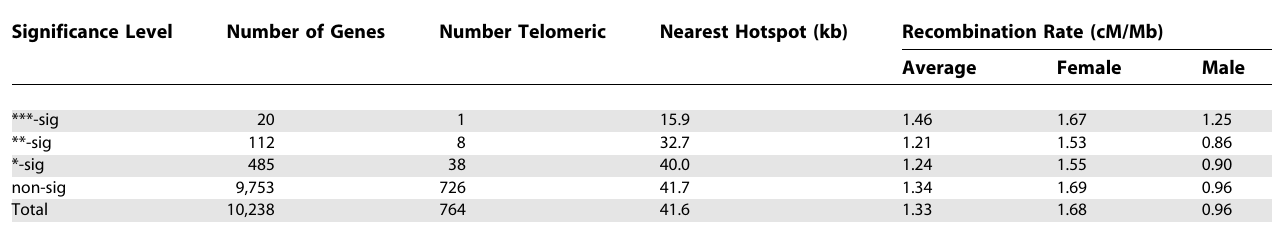
Table 7. Recombination Rate in Genes with Human-Accelerated d N /d S Significance Level